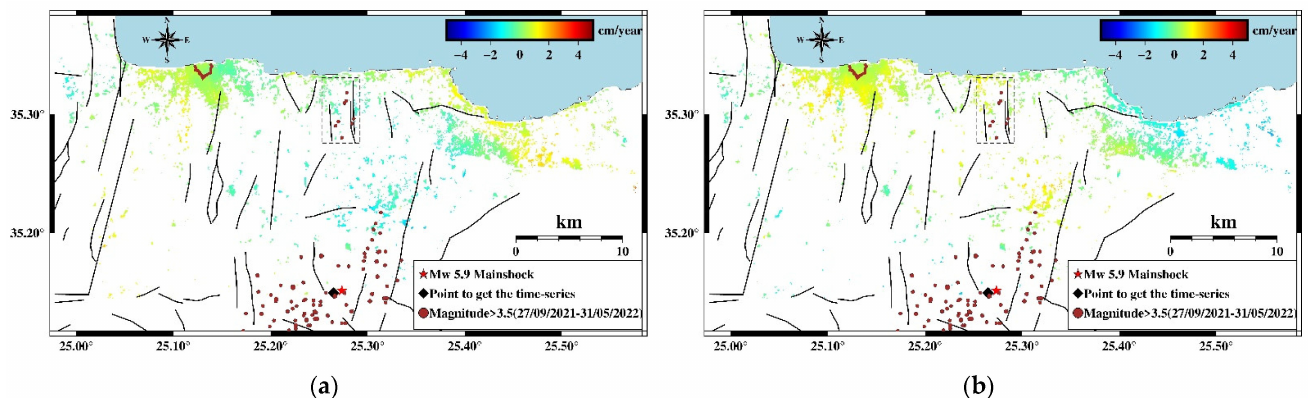
Figure 8. Two-dimensional deformation rate maps. The brown line represents the outline of the HCW. Black dash line marked the location of the 16-18 January, 2022, earthquake sequence larger than M 3.5 recorded by NOA-IG. Brown dots represent the earthquake events larger than M 3.5 during the entire observing period. Black solid lines represent the known faults referred to [7]. ( a ) EW deformation rates, positive to the east; ( b ) UD deformation rates, positive uplift.